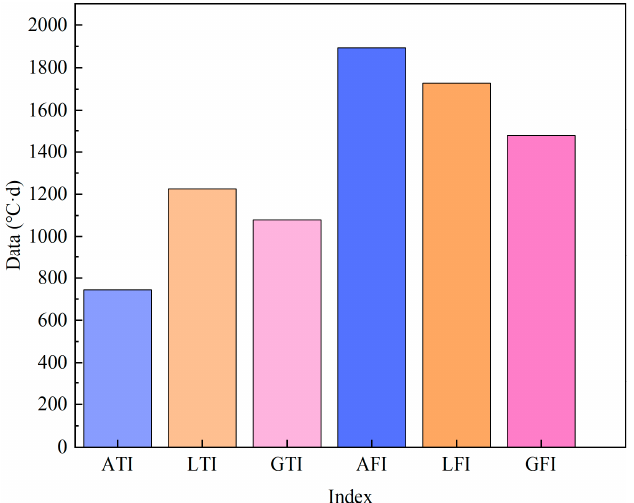
Figure 8. Three types of freezing indexes and thawing indexes in the Beiluhe weather station from 2020 to 2022. 2020 to